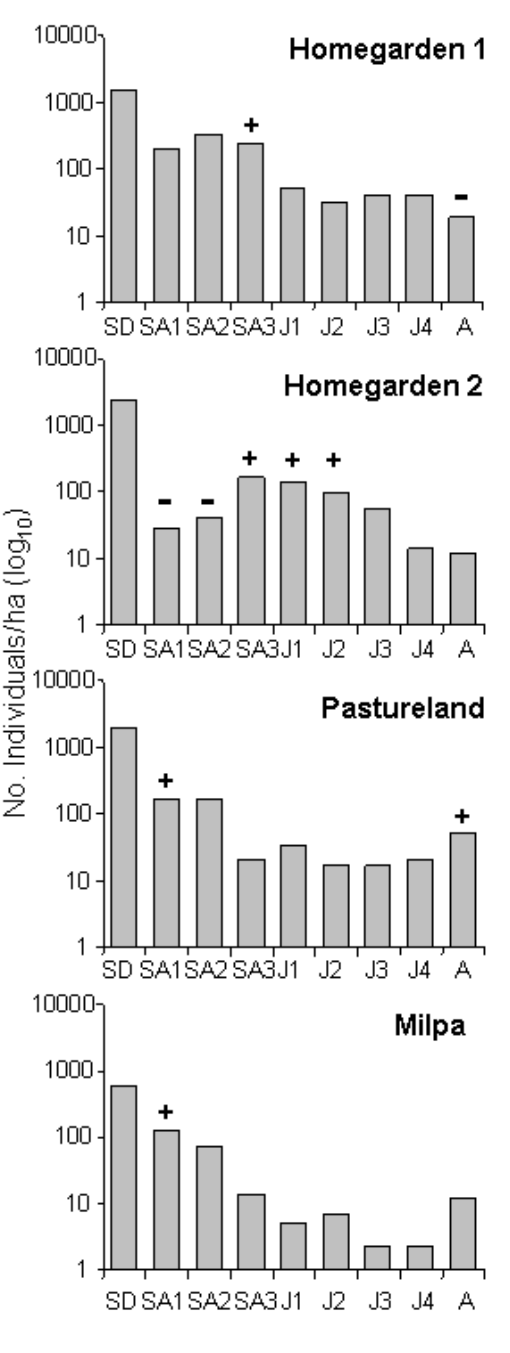
Fig. 2. Palm density and population structure. The +/- symbols indicate significant differences after a Haberman-adjusted residual test ( c 2 = 92.01, p <